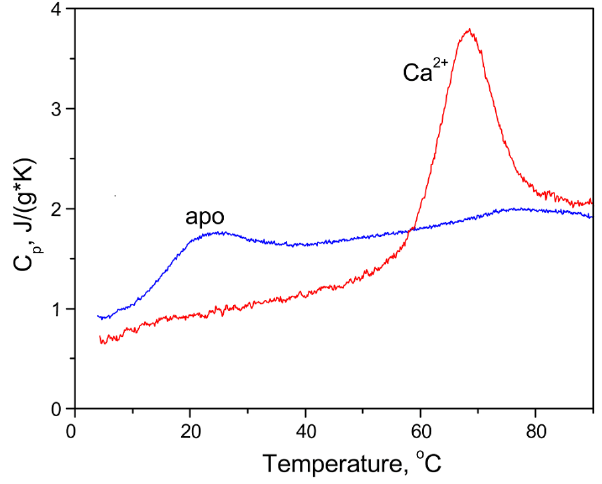
Figure 3. Heat sorption curves for apo-(1 mM EGTA) and Ca 2+ -loaded (1 mM CaCl 2 ) bovine α-lactalbumin derived from differential scanning calorimetry measurements. 10 mM HEPES, pH 8.